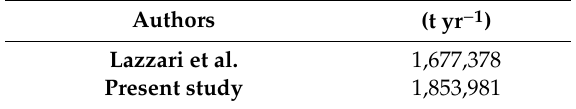
Table 4. The average soil loss predicted by RUSLE for the Camastra drainage